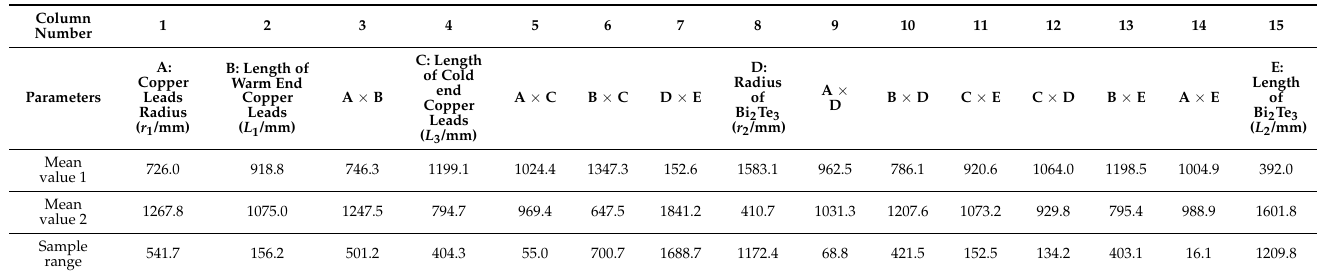
Table 5. Orthogonal experimental results of 1200 A PCLs.